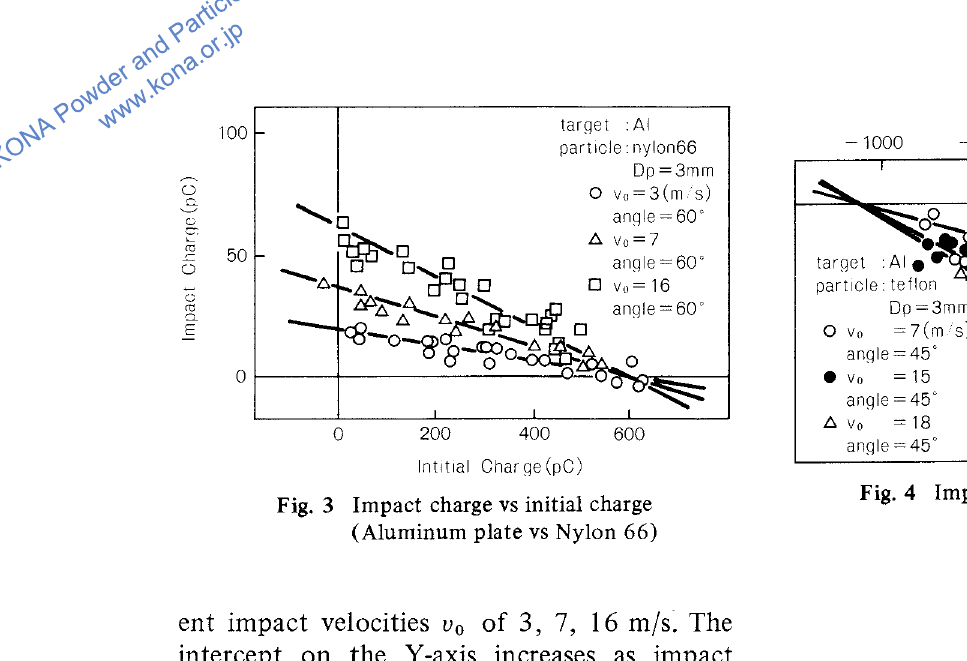
Fig. 5 Impact charge vs initial charge (Aluminum plate vs